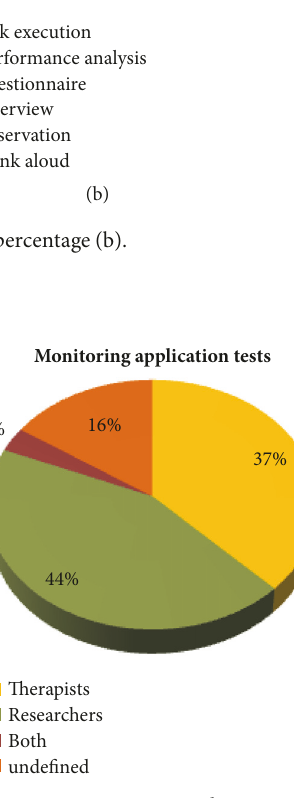
Figure 7: Monitoring application